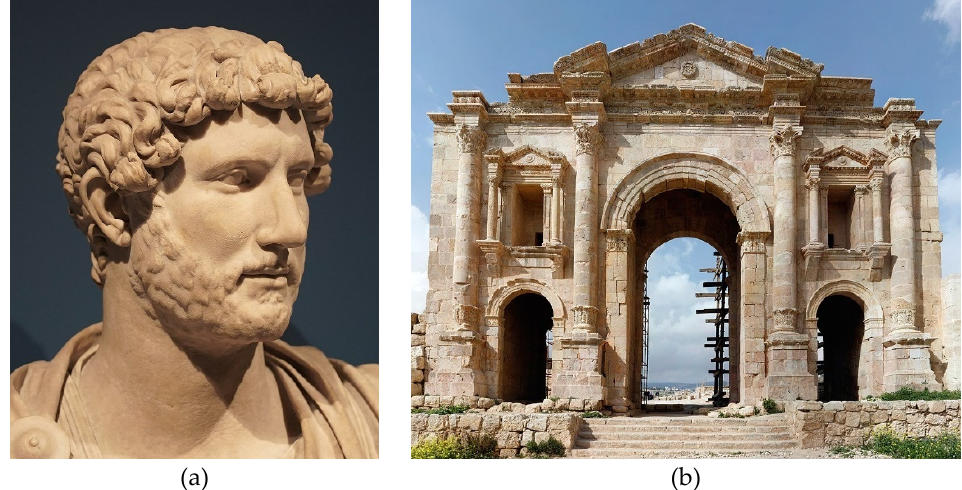
Figure 10. ( a ) Hadrian January 76–10 July 138 AD. ( b ) Arch of Hadrian in Jerash, Transjordan, built to honor Hadrian’s visit in 130 [62].